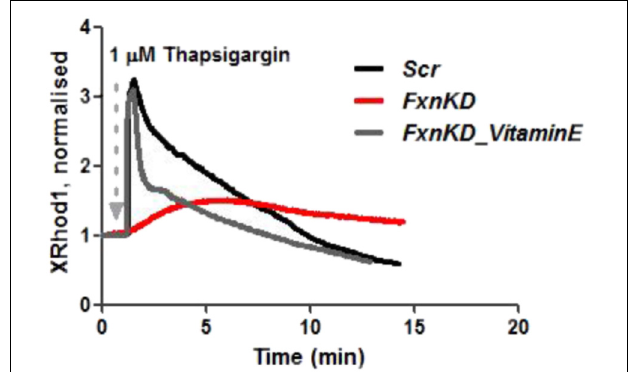
FIGURE 8 | Mitochondrial Ca 2 + is altered during Thapsigargin response. During Thapsigargin response mitochondrial Ca 2 + uptake is reduced in FxnKD cells. By pre-incubation with Vitamin E the abnormal effect induced by FxnKD was recovered during the response. However, the decay of the response was not completely restored.